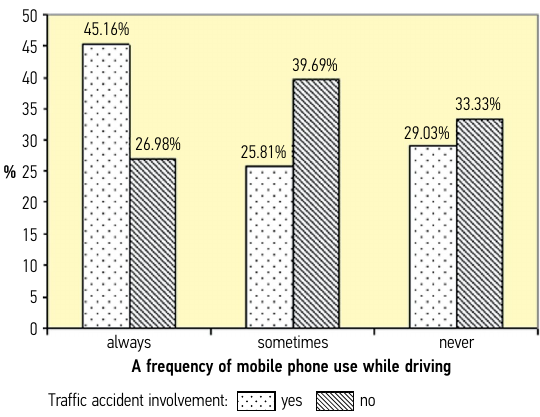
Fig. 5. The frequency of mobile phone usage and traffic accidents involvement